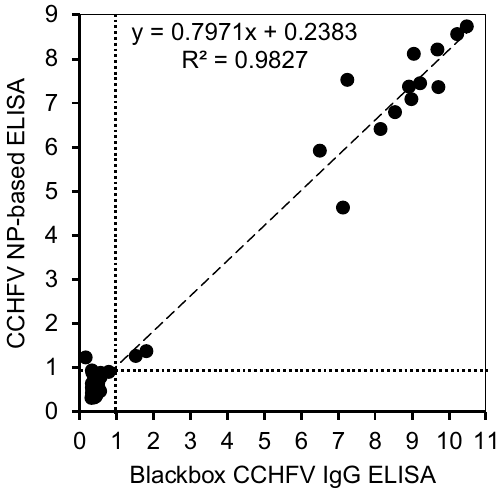
Figure 6. Correlation of IgG reactivity in human sera between the CCHFV NP-based ELISA and Blackbox- ELISA. ELISA plates were coated with purified NP (10 µg/ml). Serum samples were used at 1:100 dilution. The HRPO-conjugated protein A/G reagent (1:10,000 dilution) was used to detect bound antibodies. Scatter plots of the index values obtained by the CCHFV NP-based ELISA and Blackbox-ELISA are shown with the linear regression line (dashes). The coefficient of determination of R 2 and the cutoff lines (dotted lines) of both the CCHFV NP-based ELISA and Blackbox-ELISA are also